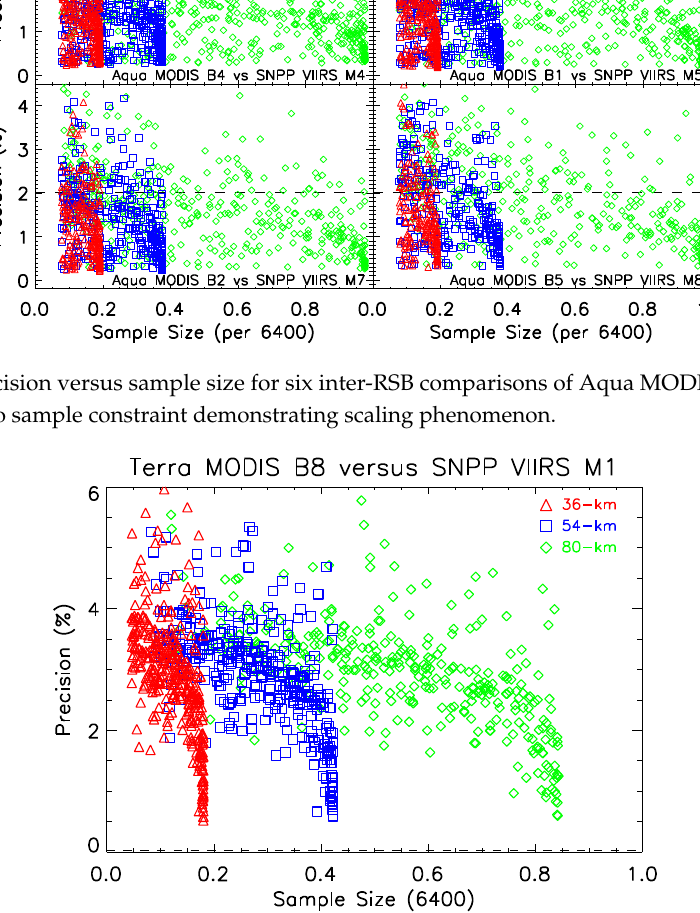
Figure 16. Precision versus sample size for Terra MODIS B8 versus SNPP VIIRS M1 under no sample constraint demonstrating scaling phenomenon.